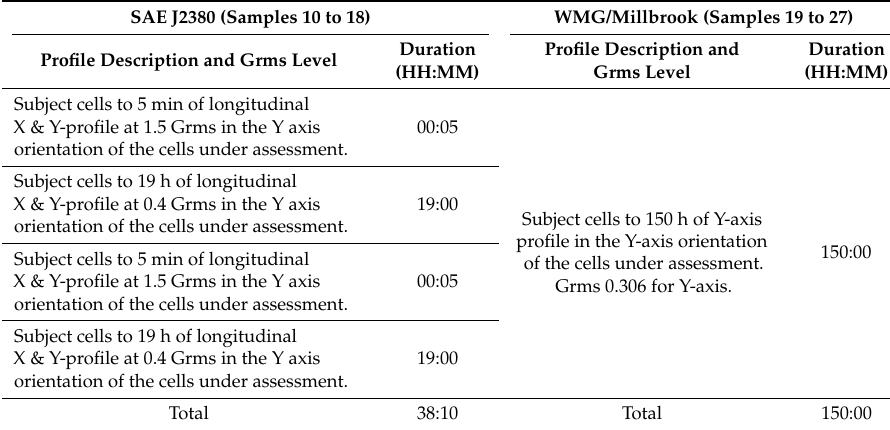
Table 4. Y axis vibration profiles